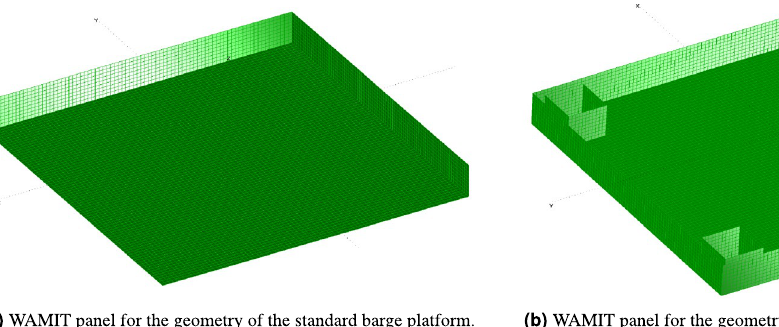
Figure 3. Platforms geometry design.